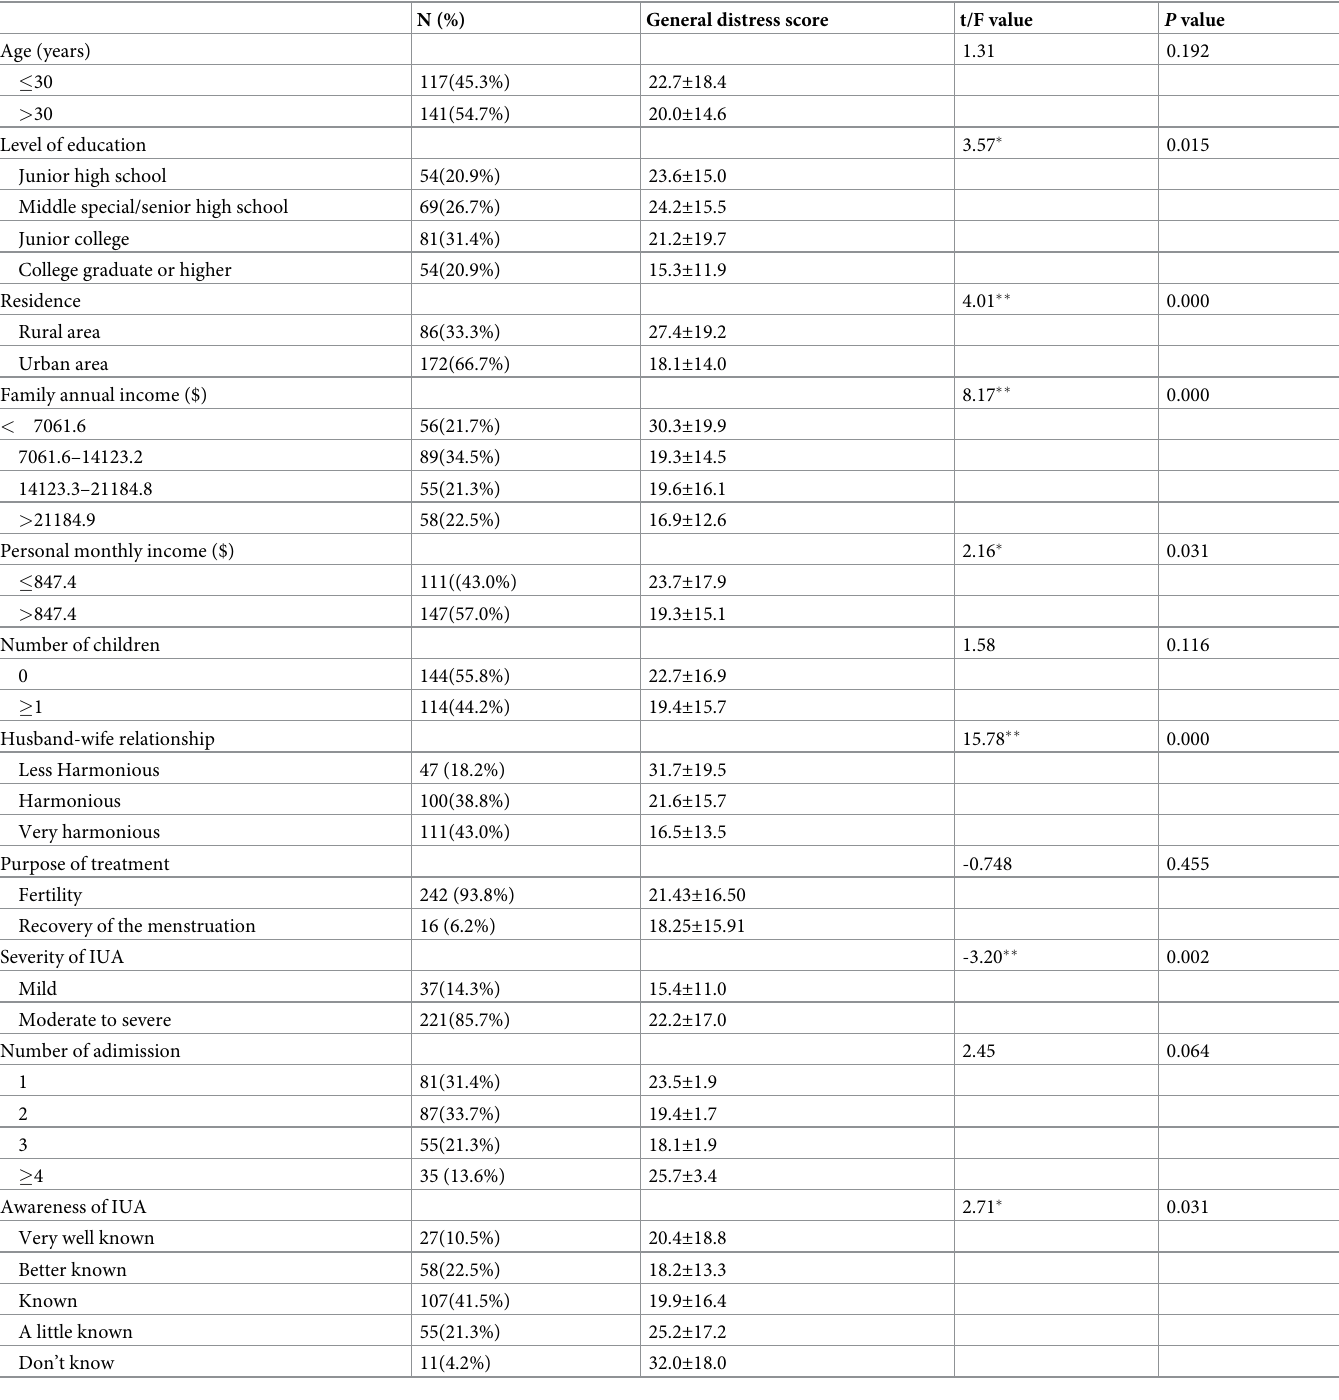
Table 1. Demographic and clinical information and associations between demographic/clinical factors and general distress score (n =